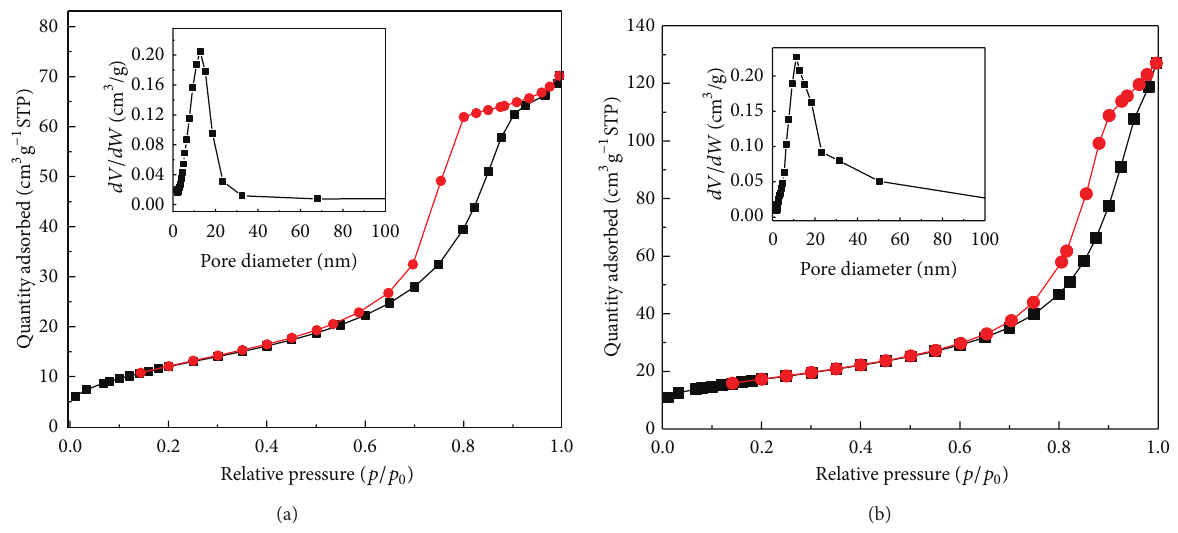
Figure 4: The N 2 sorption isotherms and pore size distribution of (a) BSO and (b) 1%-Pr-BSO.